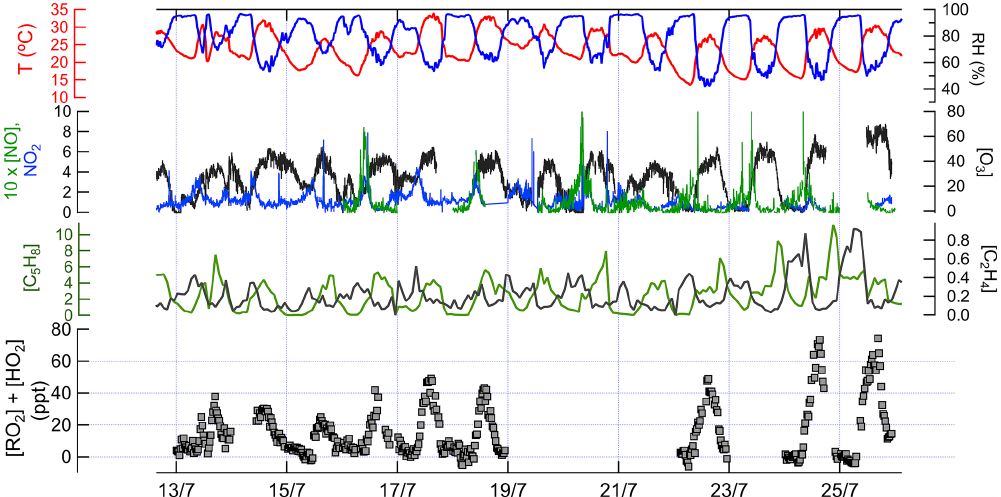
Figure 3. Time series data of measured chemical and physical parameters during IRRONIC. Except where noted, all measurements are in parts per billion. The sum of [RO 2 ] and [HO 2 ] was measured by the ECHAMP instrument, with a detection limit typically between 1 and 2ppt (signal-to-noise ratio of 2). The vertical grid lines indicate midnight for odd-numbered days, in local time.